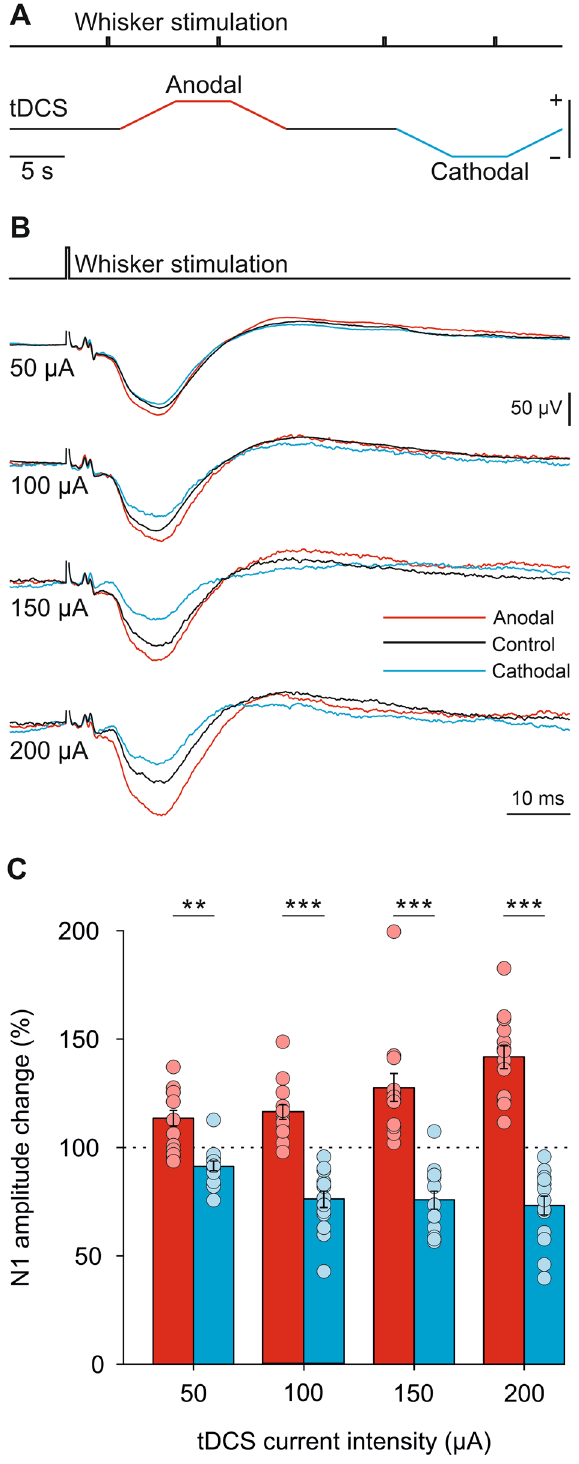
Figure 3. tDCS immediate effects over SEPs in S1 cortex. ( A ) Schematic representation of tDCS protocol. ( B ) SEP average (n = 30) from a representative animal during control (black trace), anodal (red trace) and cathodal (blue trace) tDCS applied at 50, 100, 150 and 200 μA. ( C ) Quantification and statistical results of anodal tDCS (red histograms) and cathodal tDCS (blue histograms) effects on SEP amplitude. Mean (bars) and individual amplitude data (circles) are represented as percentage of change with respect to control values for all animals (n = 14 mice). Two-way repeated-measures ANOVA, CURRENT INTENSITY effect, F 3,39 = 3.316, p = 0.030, POLARITY effect, F 1,13 = 51.081, p < 0.001, CURRENT INTENSITY × POLARITY interaction, F 3,39 = 27.818, p < 0.001, Holm-Sidak post hoc test. ** p < 0.01; *** p <